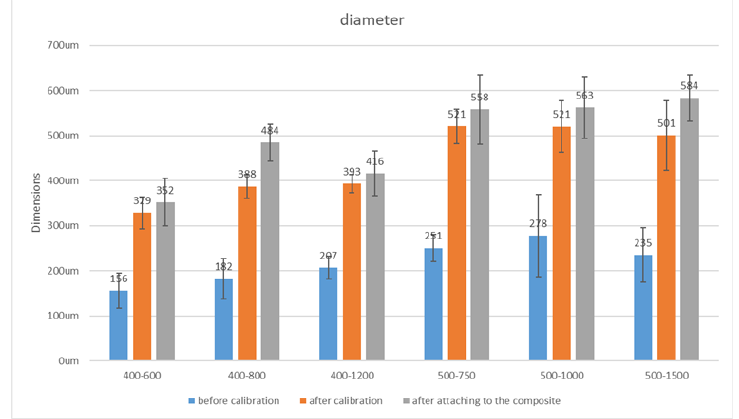
Figure 7: The samples' diameters were measured using a stereomicroscope. The original designs were later modified by adding 200 um for the diameters. This was done due to the limitations of the printer and to make the diameter close to the intended designs.